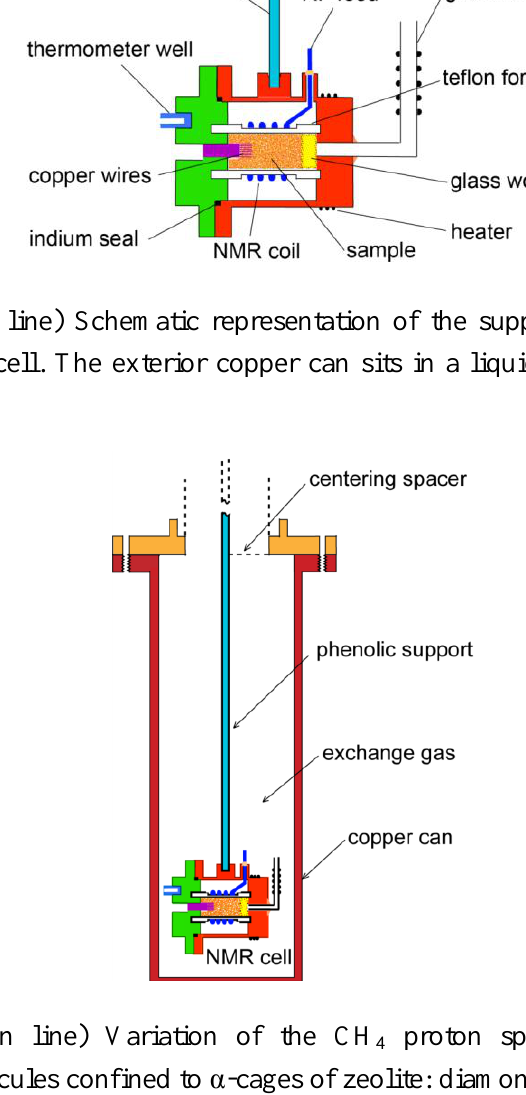
proton spin-lattice relaxation with 4